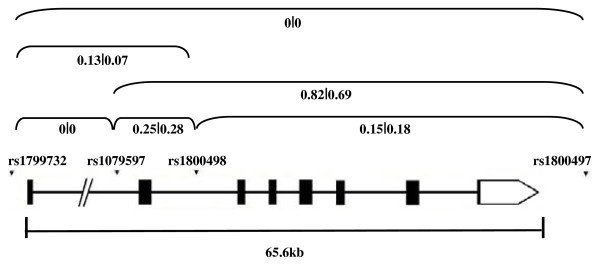
Illustration of the DRD2 locus. A schematic showing gene structure, marker positions and measures of linkage disequilibrium between rs1799732, rs1079597, rs1800498 and rs1800497 listing r2 of the comparison group (N=244) followed by r2 of parents from families (N=213). Legend: ▪ exon; ━ intron; □ untranslated region.